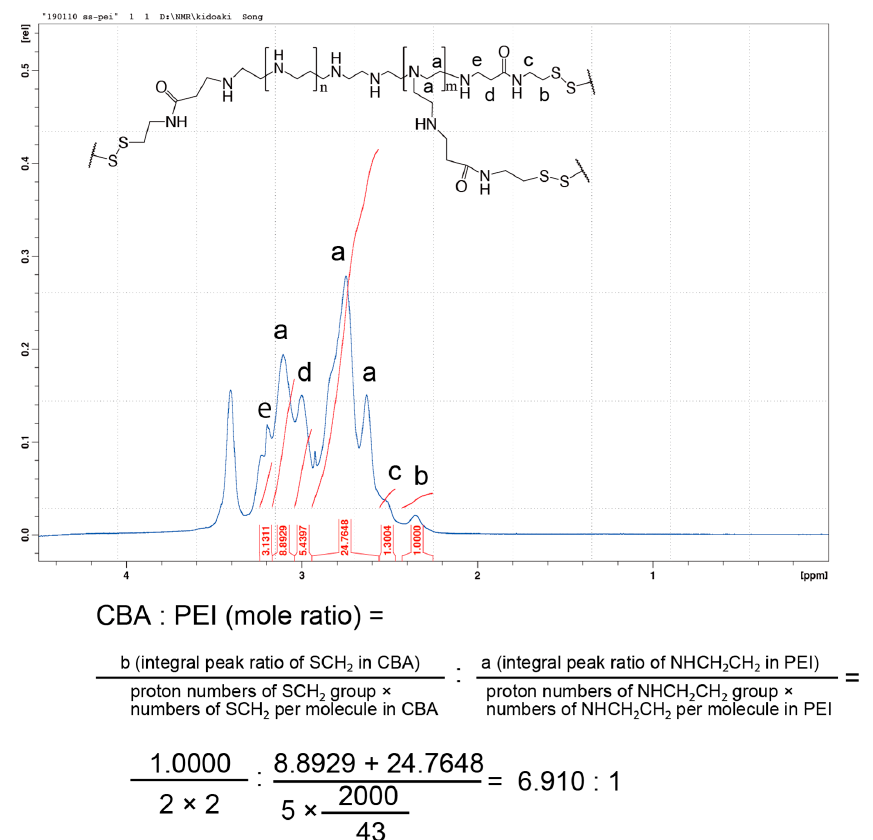
Figure1. Nuclearmagneticresonancechartsandschemesof N,N (cid:48) -bis(acryloyl)cystamine(CBA)-conjugated Figure 1. Nuclear magnetic resonance charts and schemes of N,N ′ -bis(acryloyl)cystamine (CBA)- polyethyleneimine (PEI). conjugated polyethyleneimine (PEI).